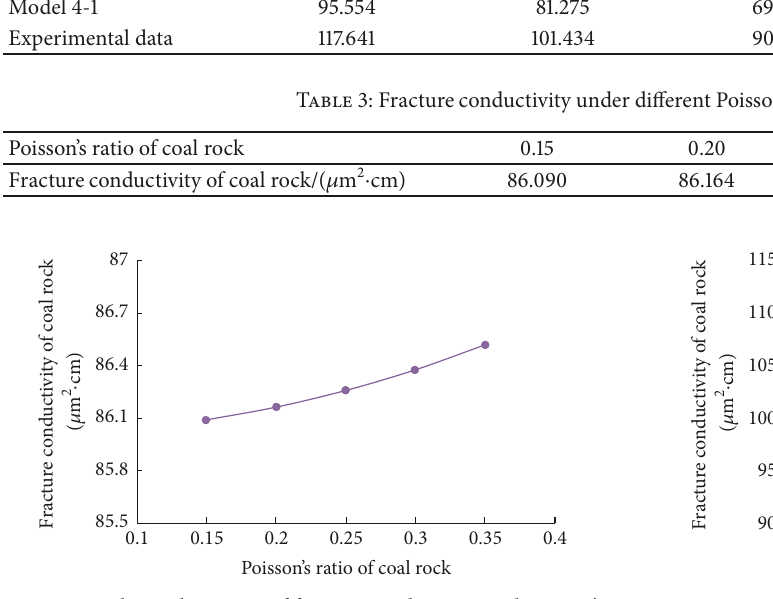
Figure 9: Relationship curve of fracture conductivity and elastic modulus of coal